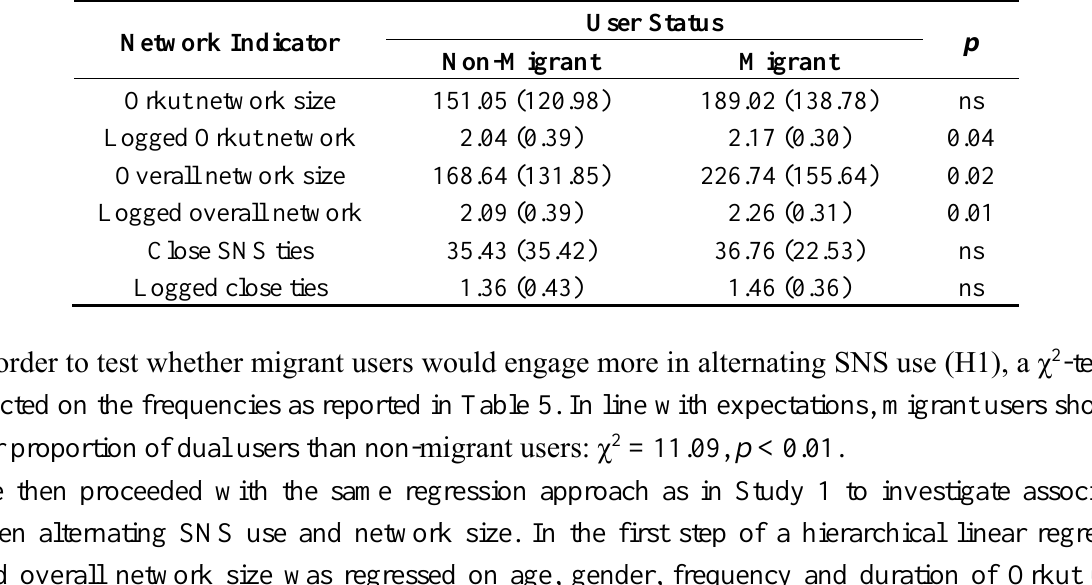
Table 6. Mean scores and standard deviations (in parentheses) for non-migrant and migrant